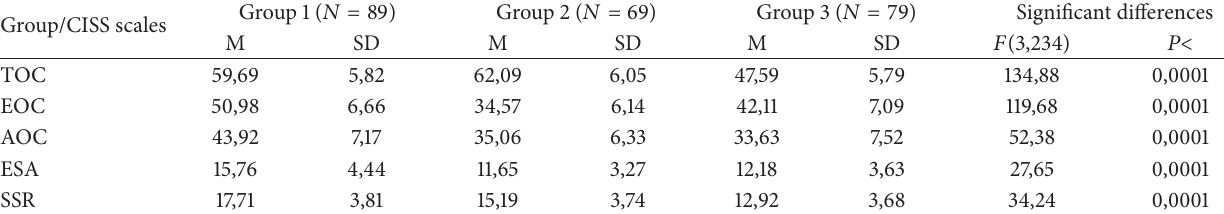
Table 1: Coping styles in three groups of patients: comparison.